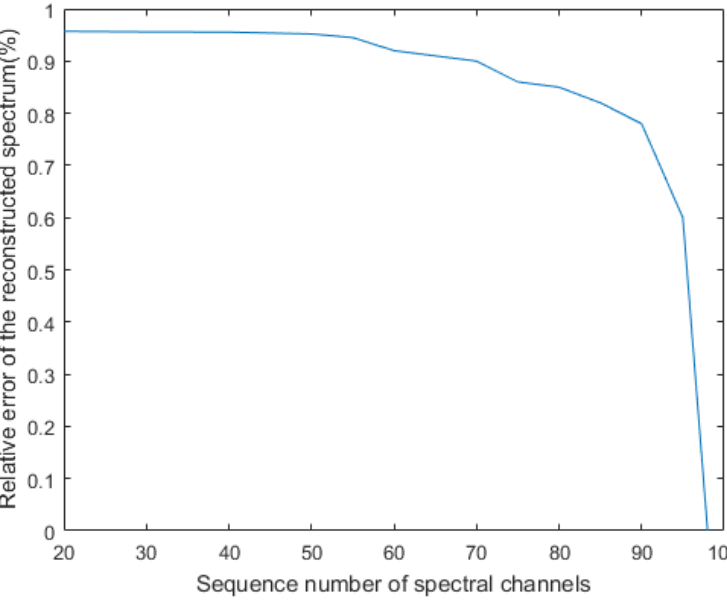
Figure 11. Effect of the number of equations on the accuracy of spectral